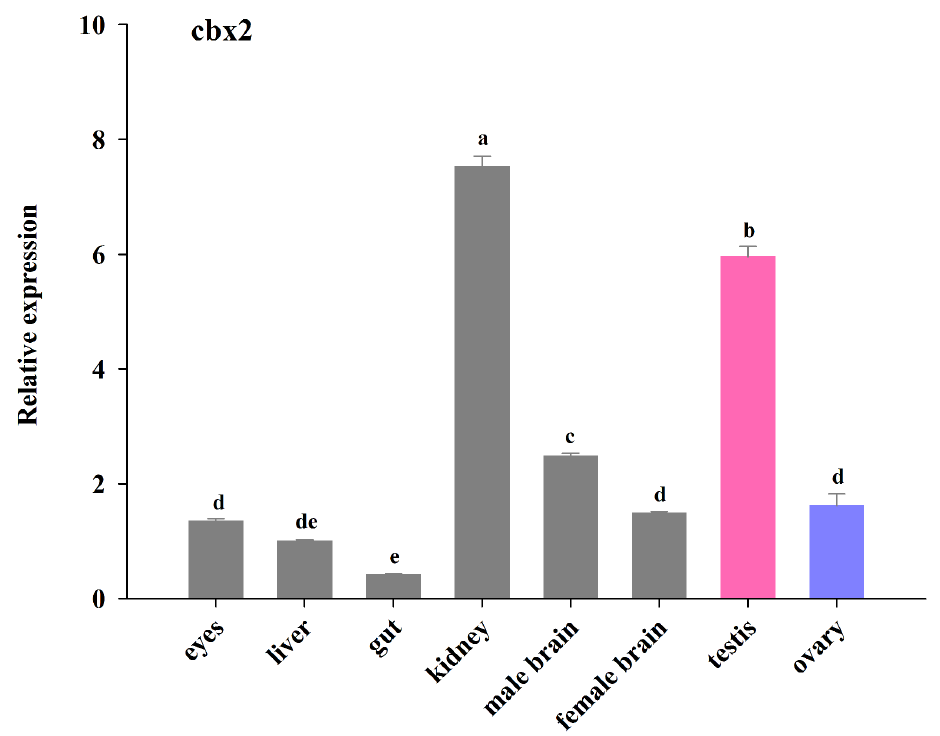
Figure 4. The relative expression of cbx2 mRNA in different medaka tissues. The different alphabetic signs indicate statistically significant differences ( P < 0.05).